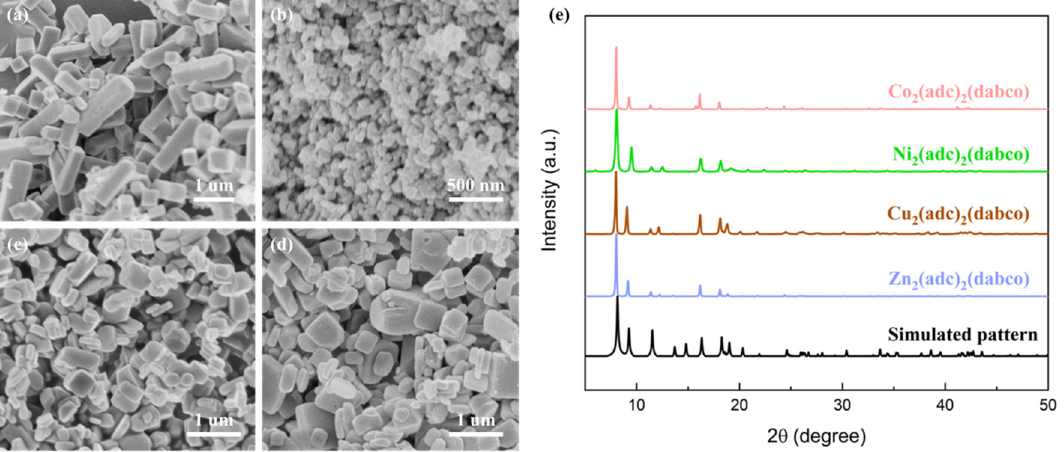
Figure 1. The scanning electron microscopy (SEM) images for the obtained MOFs. ( a ) Co 2 (adc) 2 (dabco); ( b ) Ni 2 (adc) 2 (dabco); ( c ) Cu 2 (adc) 2 (dabco); ( d ) Zn 2 (adc) 2 (dabco). ( e ) The powder X-ray diffraction (PXRD) patterns of the MOFs [M 2 (adc) 2 (dabco)] (M = Co, Ni, Cu, Zn) and the simulated pattern for the reported Zn 2 (adc) 2 (dabco) (CCDC: 814078)